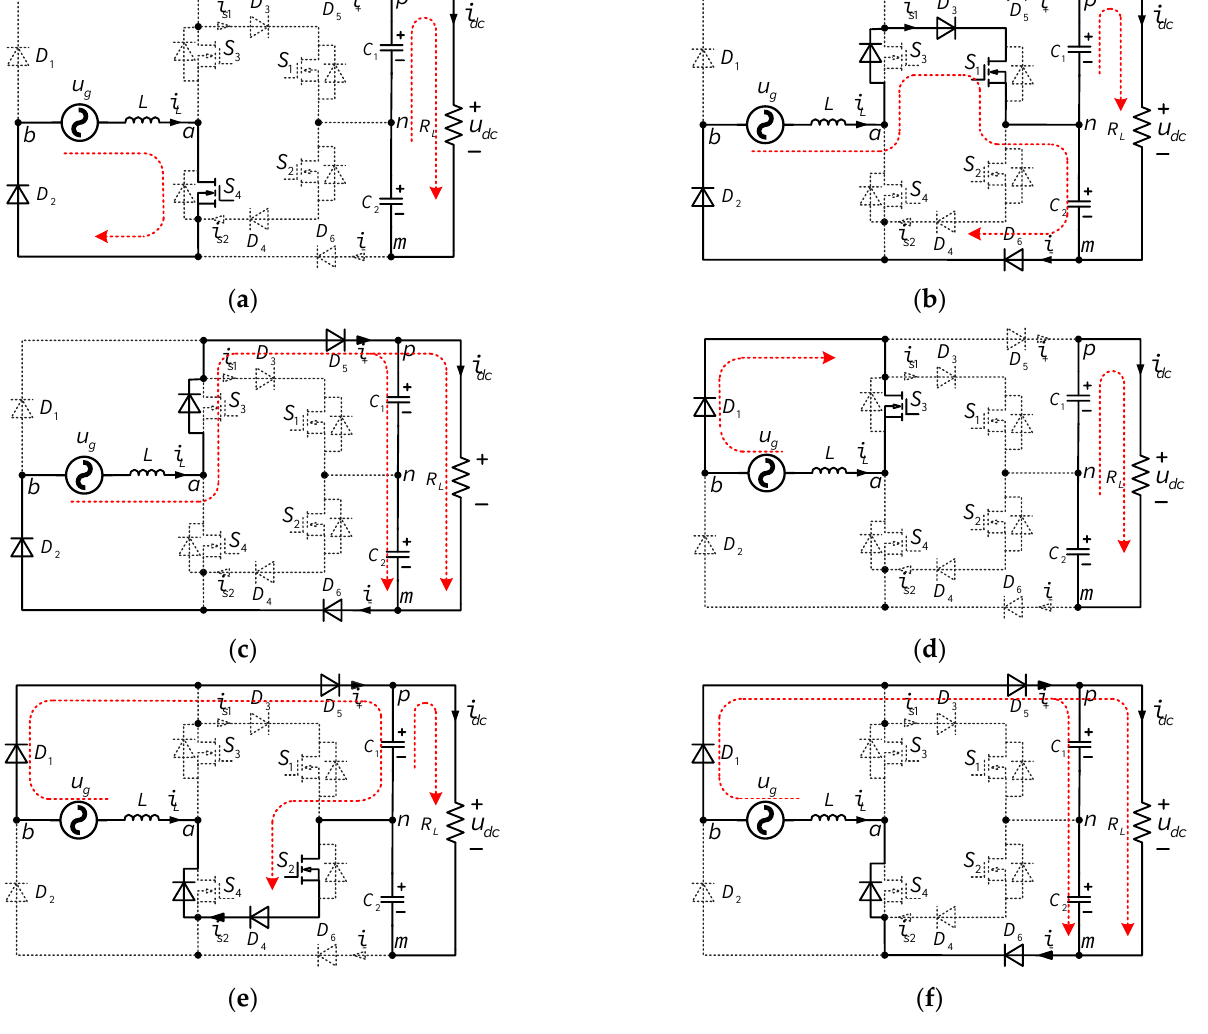
Figure 4. Current paths corresponding to six operating modes of the STL-PFC: ( a ) Mode 1 ( i L > 0, u ab = +0); ( b ) Mode 2 ( i L > 0, u ab = +0.5 u dc ); ( c ) Mode 3 ( i L > 0, u ab = + u dc ); ( d ) Mode 4 ( i L < 0, u ab = −0); ( e ) Mode 5 ( i L < 0, u ab = −0.5 u dc ); ( f ) Mode 6 ( i L < 0, u ab = − u dc ).